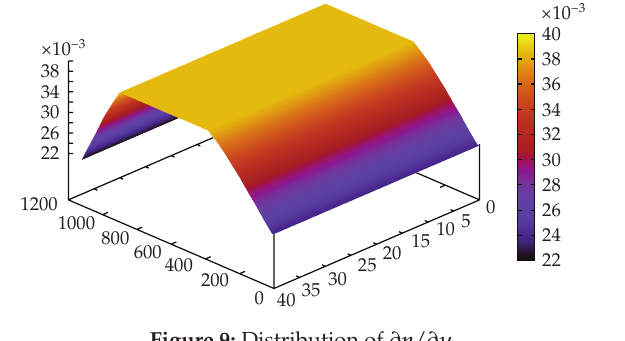
Figure 9: Distribution of ∂η/∂y .